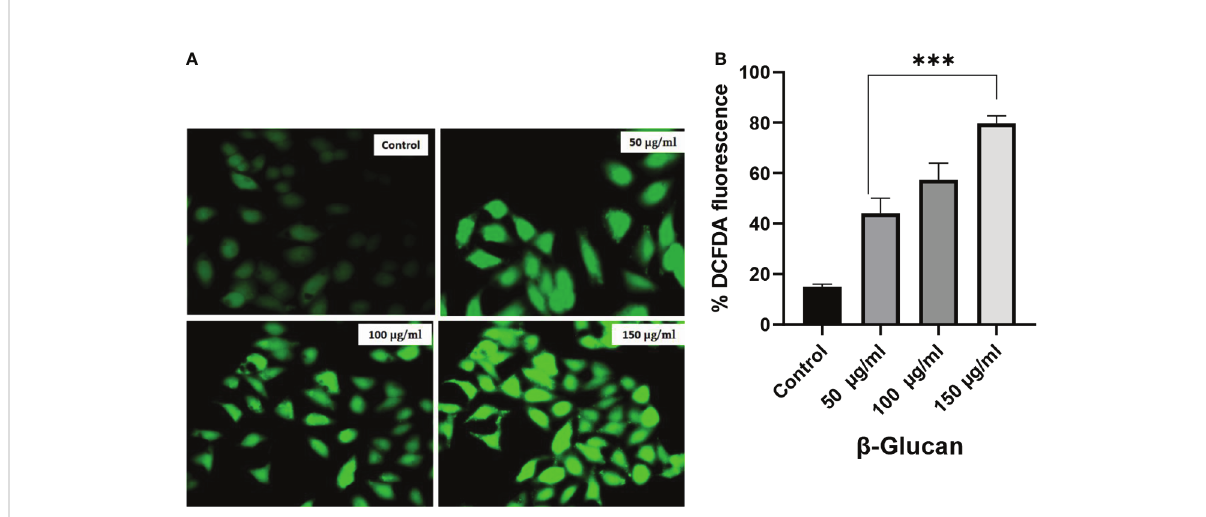
FIGURE 10 (A) Effect of yeast b -glucan on cellular ROS generation. Overproduction of cellular ROS in HeLa cells was induced by treatment with yeast b - glucan in 50 – 150 m g/ml for 24 h. Relative fl uorescence of ROS was detected by cell membrane-permeable fl uorescent dye H2DCFDA. Error bars are an indication of standard deviation. (B) One-way ANOVA performed with the help of GraphPad Prism 8.0 software showing 50, 100, and 150 m g/ml treatments as signi fi cant with p-value less than 0.05 (p < 0.05). Quantitative estimation performed with ImageJ software and fl uorescence intensity measured as intensity of DCFDA. Minimum ROS generation in terms of DCFDA fl uorescence was observed in control well, ROS generation increased with increase in treatment concentration, and maximum ROS generation was observed at 150 m g/ml. ROS, reactive oxygen species. ***Highly signi fi